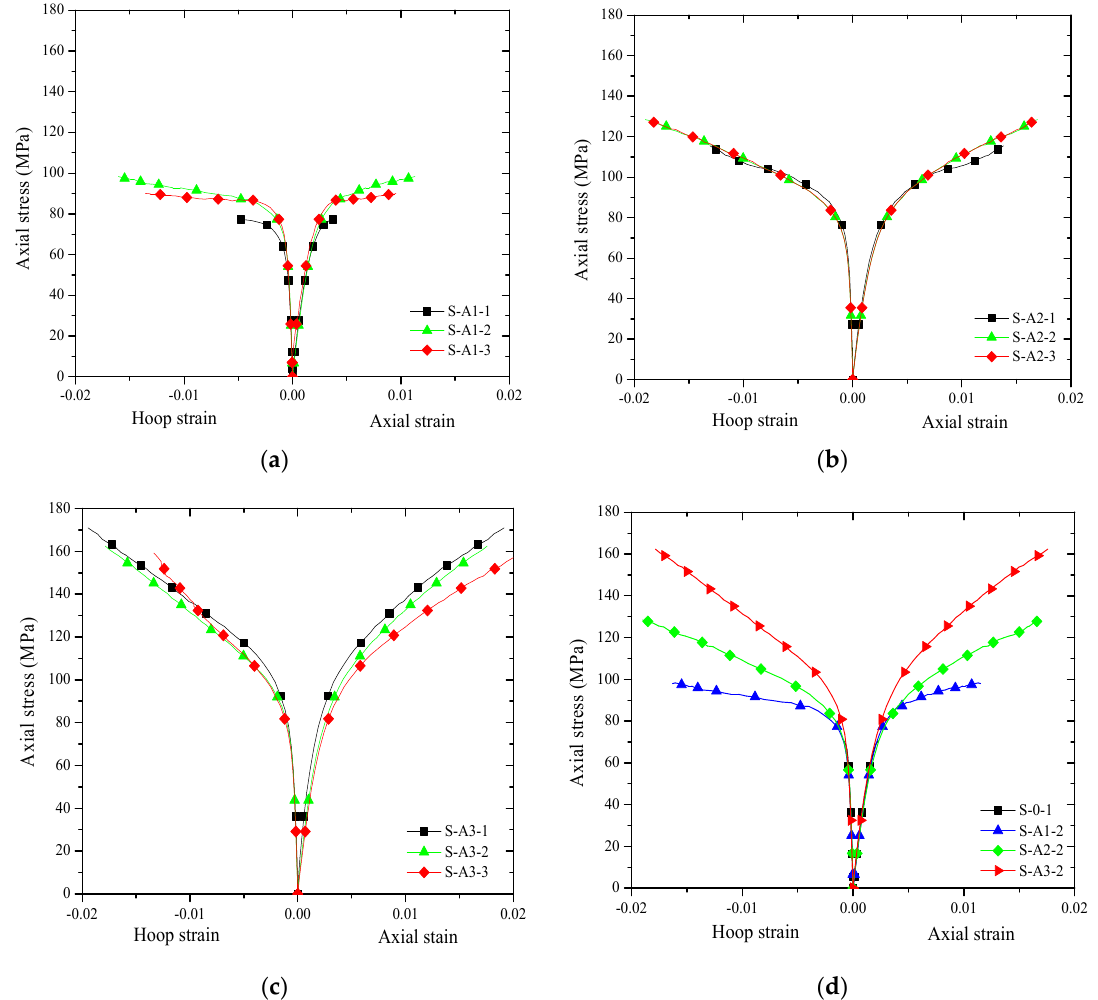
Figure 6. Stress–strain curves of the AFRP-confined concrete specimens under quasi-static compression. ( a ) One-layer AFRP-confined specimens; ( b ) Two-layer AFRP-confined specimens; ( c ) Three-layer AFRP-confined specimens; and ( d ) AFRP-confined and unconfined specimens.